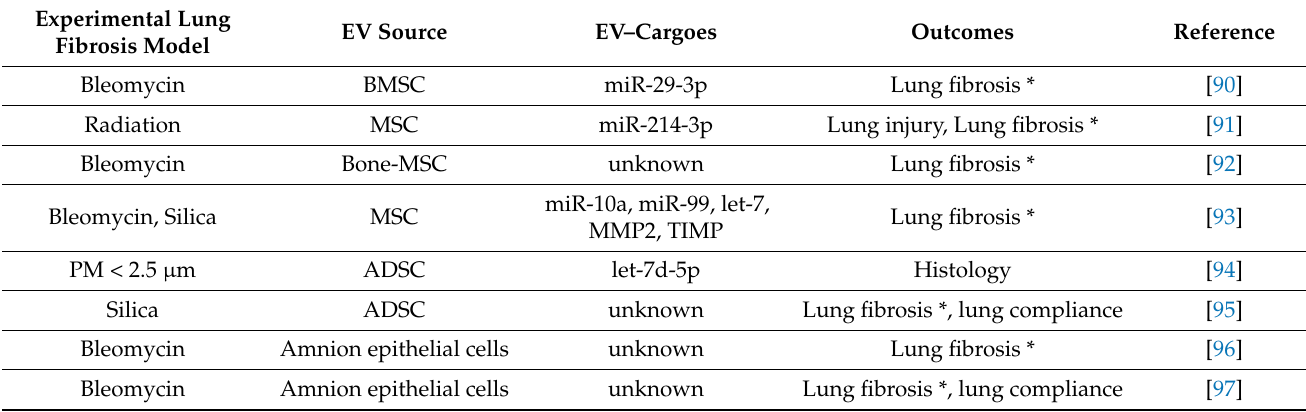
Table 1. Preclinical therapeutic application of EVs in interstitial lung diseases and